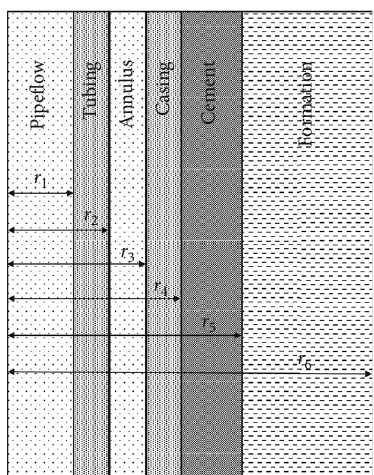
Figure 1: Structure of the vertical segment of a complex wellbore.